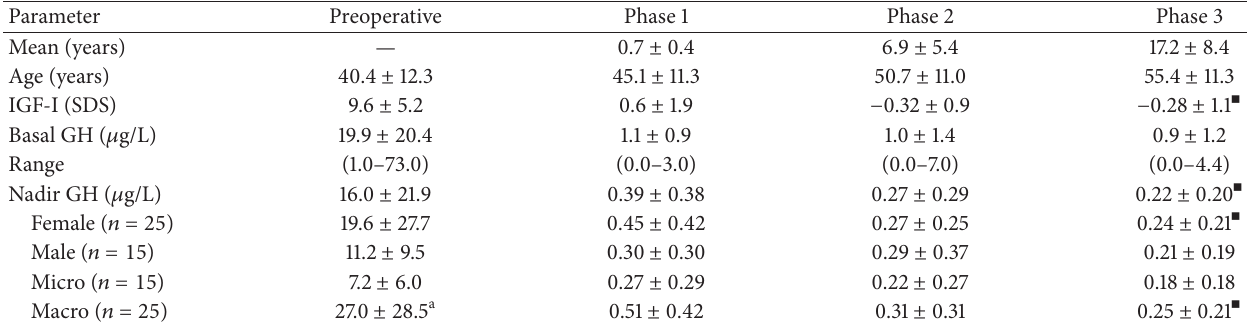
Table 1: Pre- and postoperative hormonal data of overall acromegalic patients ( 𝑛 = 40 ) during longitudinal follow-up; postglucose GH nadir levels are additionally categorized by sex and tumor size. Mean ± SD values are